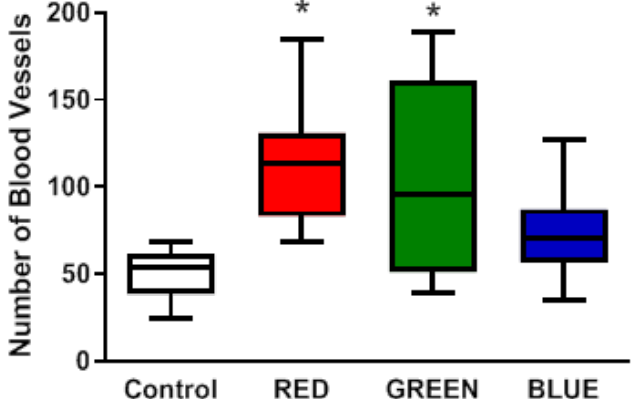
Figure 7. Effects of pulsing LED light therapy on the formation of new blood vessels in the wound area after the treatment period of 28 days. Wounds were excised and treated with different wavelengths for 6 min every second day for 28 days. Blood vessels were visualized by von Willebrand factor (vWF) immunohistochemical staining and counted in the region of interest (ROI), 2 × 2 mm in the middle of the wound surface. * p < 0.05 compared to the control group.